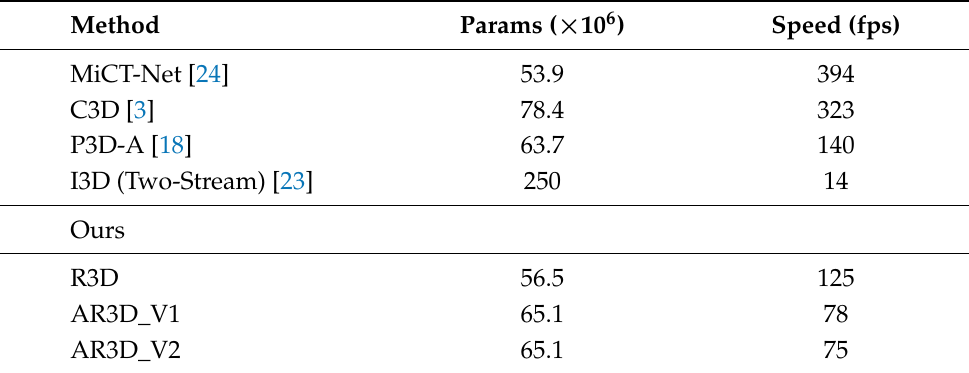
Table 5. Model parameters and speed